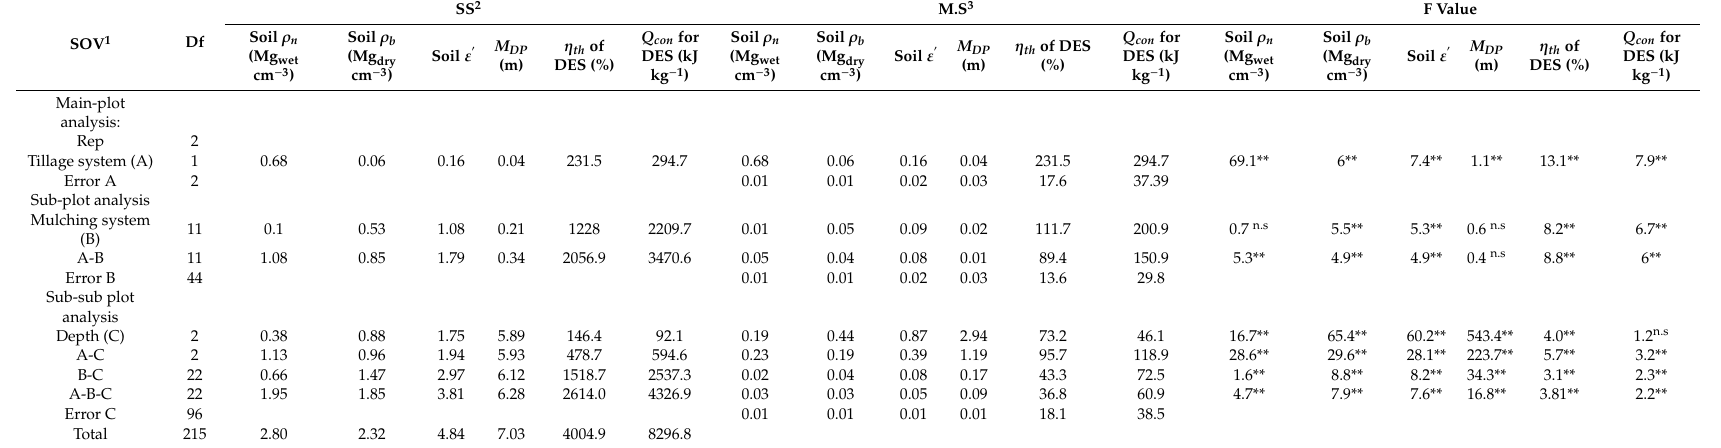
Table 5. Descriptive statistics of parameters studied under influences of experimental